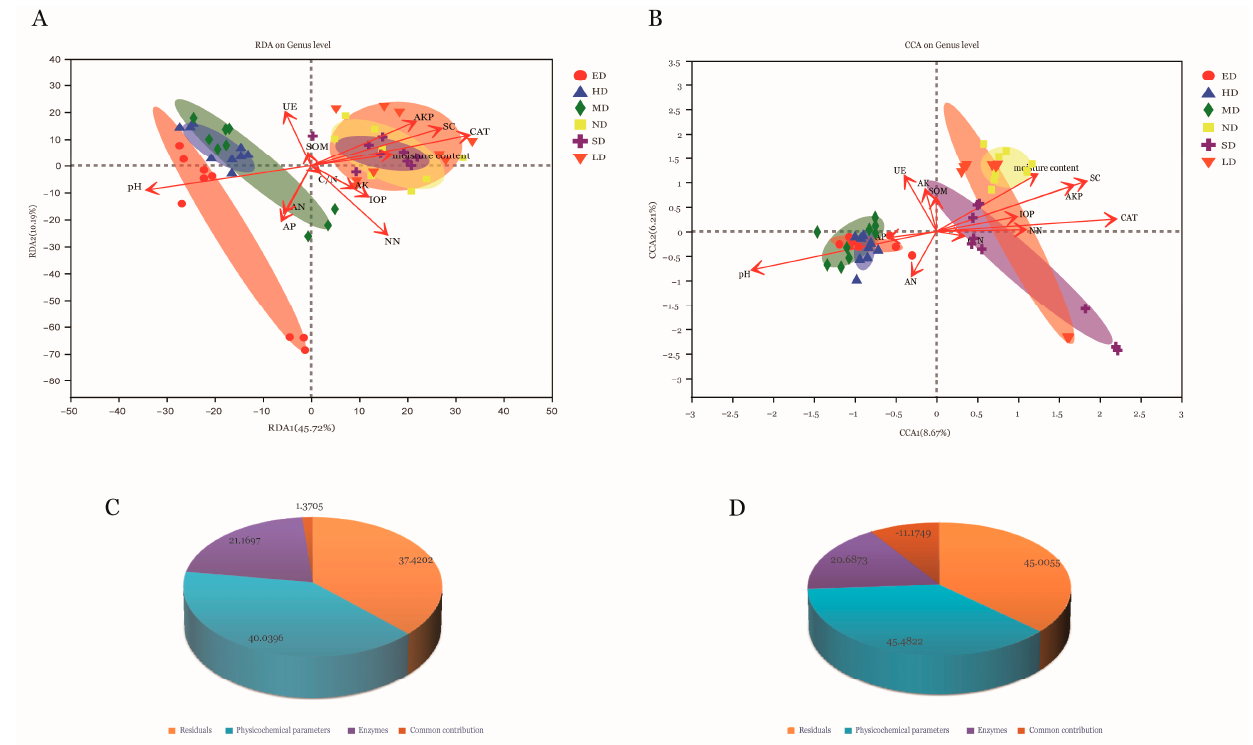
Figure 5. Relationships between microbial communities at the genus level and environmental factors. ( A ) Redundancy analysis (RDA) of the soil bacterial community; ( B ) canonical correspondence analysis (CCA) of the soil fungal community; shapes of different colors represented the soil microbial communities under different vegetation types; and the environmental factors were indicated by red arrows. C/N: soil carbon-nitrogen ratio; IOP: inorganic phosphorus; AP: available phosphorus; NN: nitrate nitrogen; AN: ammonium nitrogen; AK: available potassium; SOM: soil organic matter; SC: soil sucrase activity; UE: urease activity; CAT: catalase activity; AKP: alkaline phosphatase activity. C, D: Variance partitioning analysis (VPA) of bacterial ( C ) and fungal ( D ) communities explained by soil physicochemical parameters (soil moisture, pH, C/N, IOP, AP, NN, AN, AK and SOM) and soil enzymes (SC, UE, CAT and